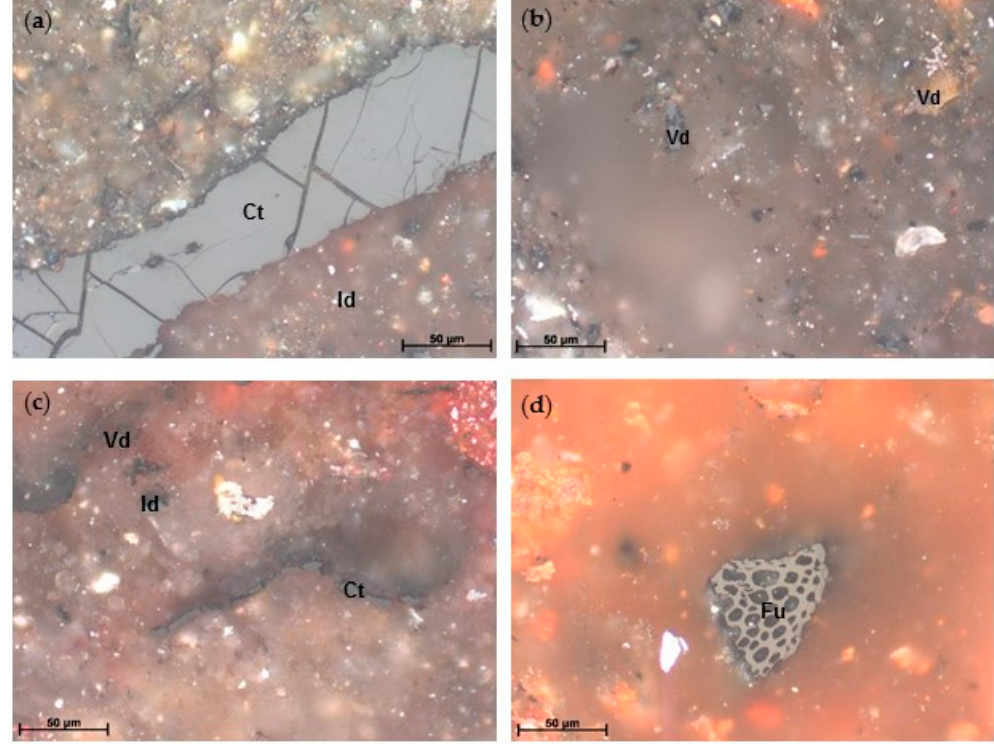
Figure 6. Macerals present in gangue rocks associated with disappearing coal seams in the northern and southern parts of the Jas-Mos mining area. ( a ) Collotelinite (Ct) with perpendicular cracks, sample N1; ( b ) vitrodetrinite (Vd), sample N3; ( c ) cracked collotelinite (Ct), vitrodetrinite (Ct) and inertodetrinite (Id), sample S2; ( d ) fusinite (Fu), sample S4. Reflected white light, immersion oil.